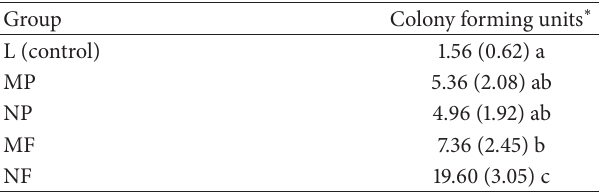
Table 5: Mean values to colony forming